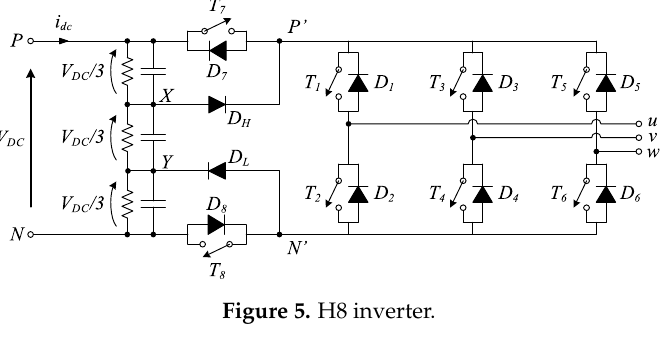
Figure 5. H8 inverter.